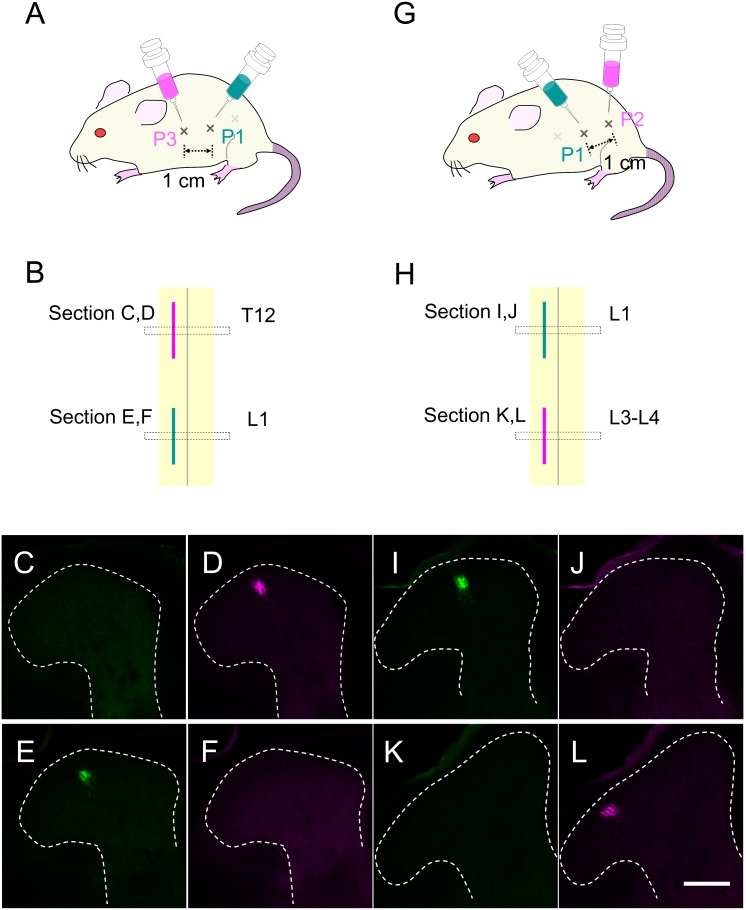
Analysis of the central projection of primary sensory neurons by use of retrograde labeling.(A–F) Alexa488 (green)- and Alexa555 (magenta)-conjugated cholera toxin B (CTB) were respectively injected into P1 and P3 in the abdomen. (A) Seven days later, transverse sections of the spinal cord were prepared. Alexa555-positive and Alexa488-positive central projections were found in the transverse sections around T12 and L1 levels, respectively (C–F). (G–L) Alexa488- and Alexa555-CTB were respectively injected into P1 and P2 in the abdomen. (G) Alexa488- and Alexa555-positive central projections were found in the transverse sections of the spinal cord around L1 and L3 to L4 levels, respectively (I–L). Scale, 100 µm.